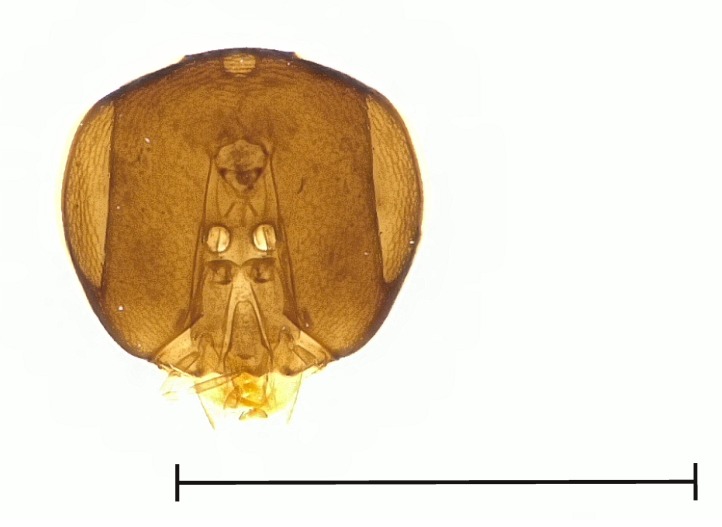
Pteromalus
achillei.